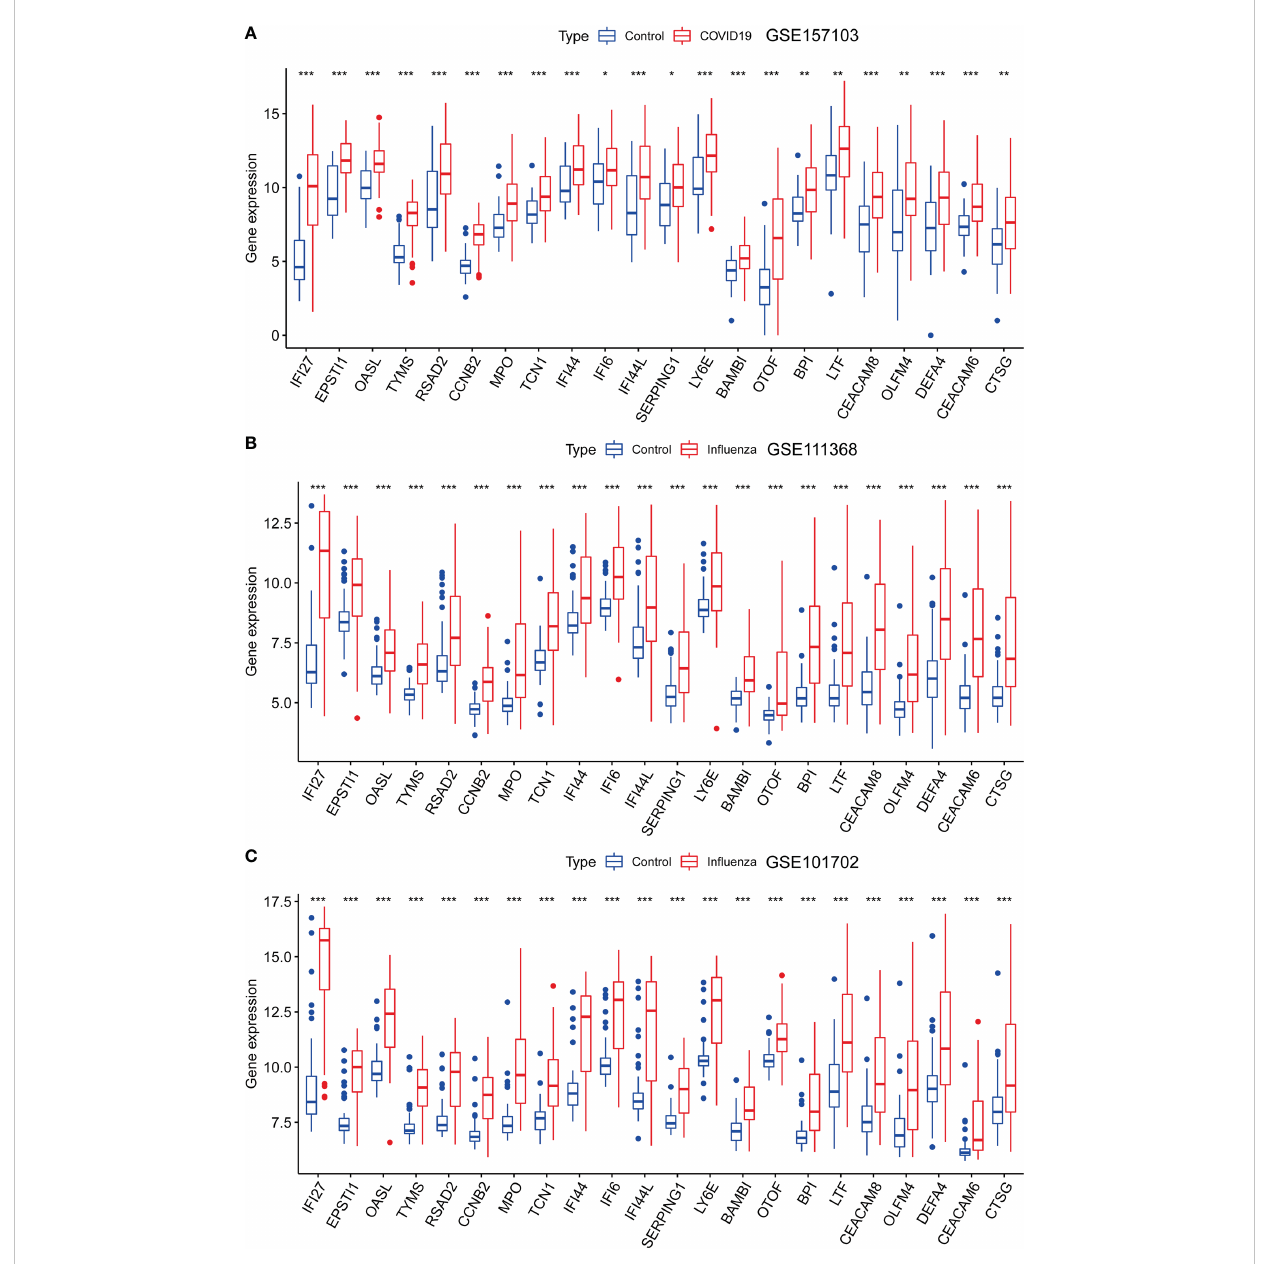
FIGURE 4 Expression analysis of the 22 DEGs in GSE157103, GSE111368, and GSE101702 datasets between types of severity and healthy control groups. (A) mRNA expression levels of 22 DEGs between control and COVID-19 in GSE157103 dataset, (B) mRNA expression levels of 22 DEGs between control and in fl uenza in GSE111368 dataset, (C) mRNA expression levels of 22 DEGs between control and in fl uenza in GSE101702 dataset (*p<0.05, **p<0.01,